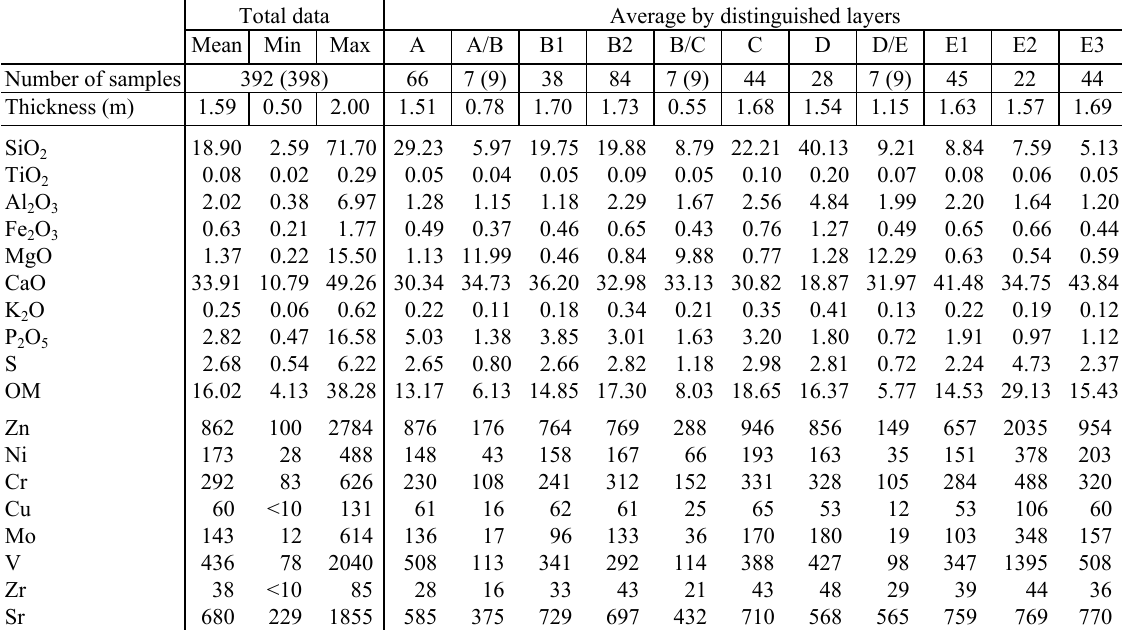
vs CaO plot) and P O -rich layer A (Fig. 2, SiO 2 2 5 O vs CaO plot). The dolomitic limestone (Fig. 2, P 2 5 Table 1. Mean, minimum and maximum concentrations of chemical elements in 392 samples and average thickness of 398 samples from nine drill cores; and average thickness and concentrations by different oil shale and barren rock layers (A–E3) distinguished in the concession area, Attarat Um Ghudran deposit, Jordan. Organic matter (OM) reflected by LOI500°C. Major elements in wt%, trace elements in ppm. (The chemical composition of dolomitic limestone layers A/B, B/C and D/E was not analysed in two drill cores) Total data Average by distinguished